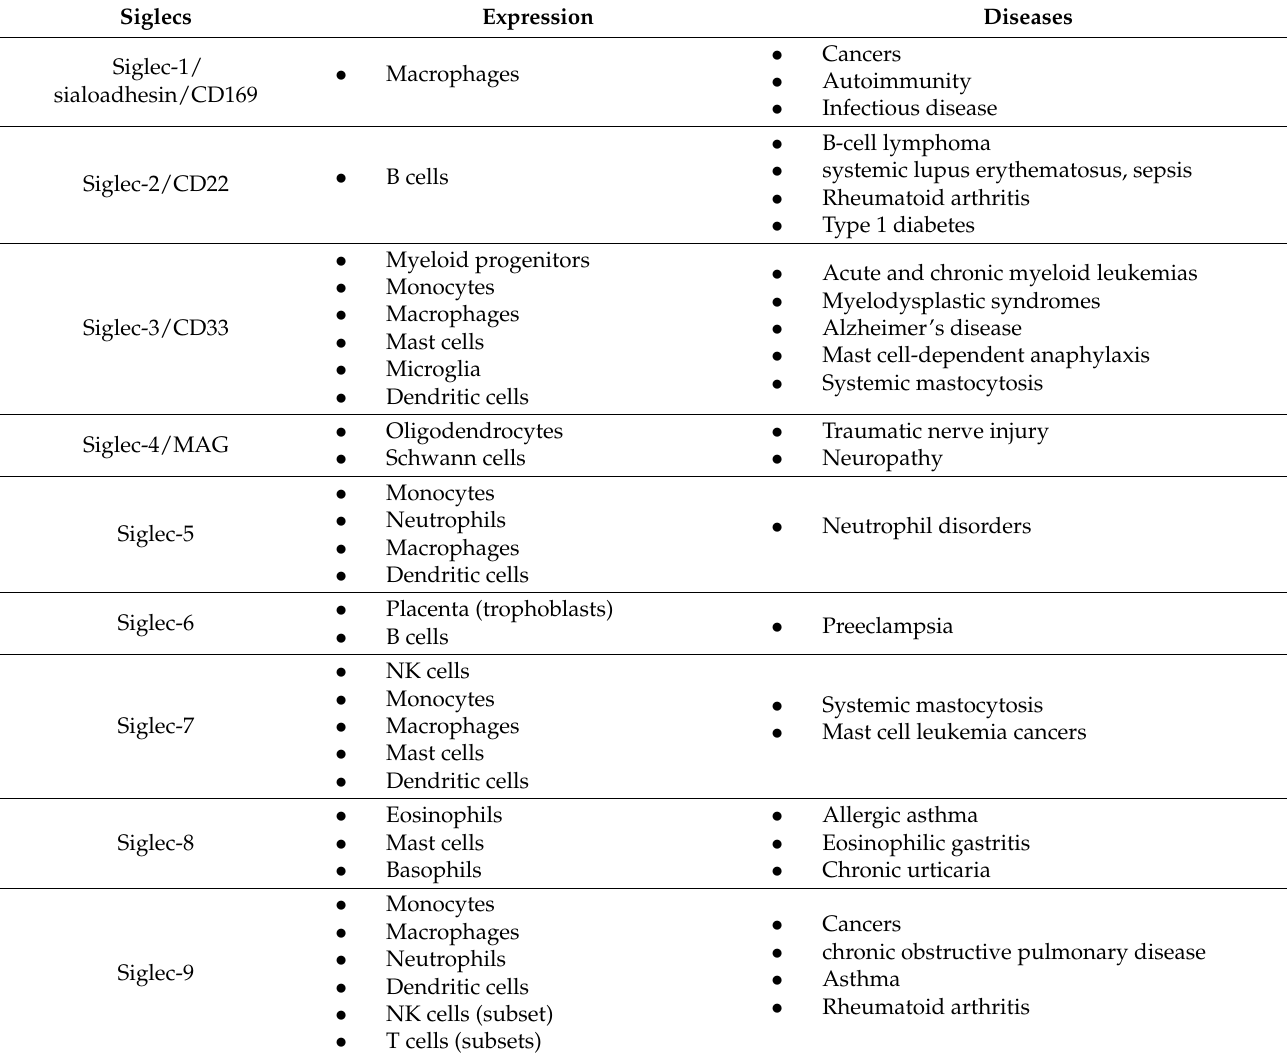
Table 1. Disease targets of Siglec and anti-Siglec therapies 1